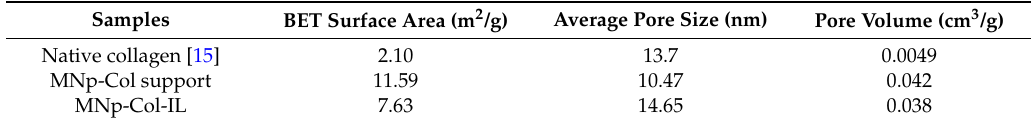
Table 1. The pore size of magnetic collagen support and immobilized